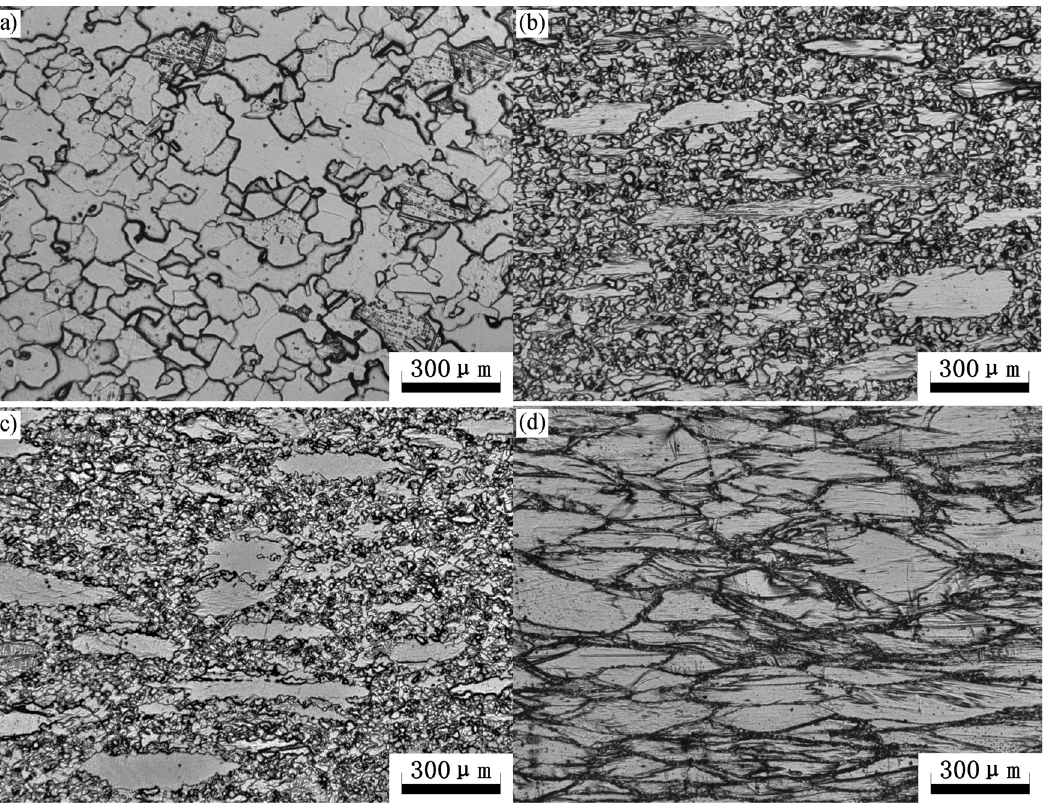
Figure 9: Microstructures of Nimonic 80A under different conditions: (a) 0.01 s – 1 , 1,200°C, (b) 5 s – 1 , 1,150°C, (c) 0.01 s – 1 , 1,000°C, (d) 1 s – 1 ,